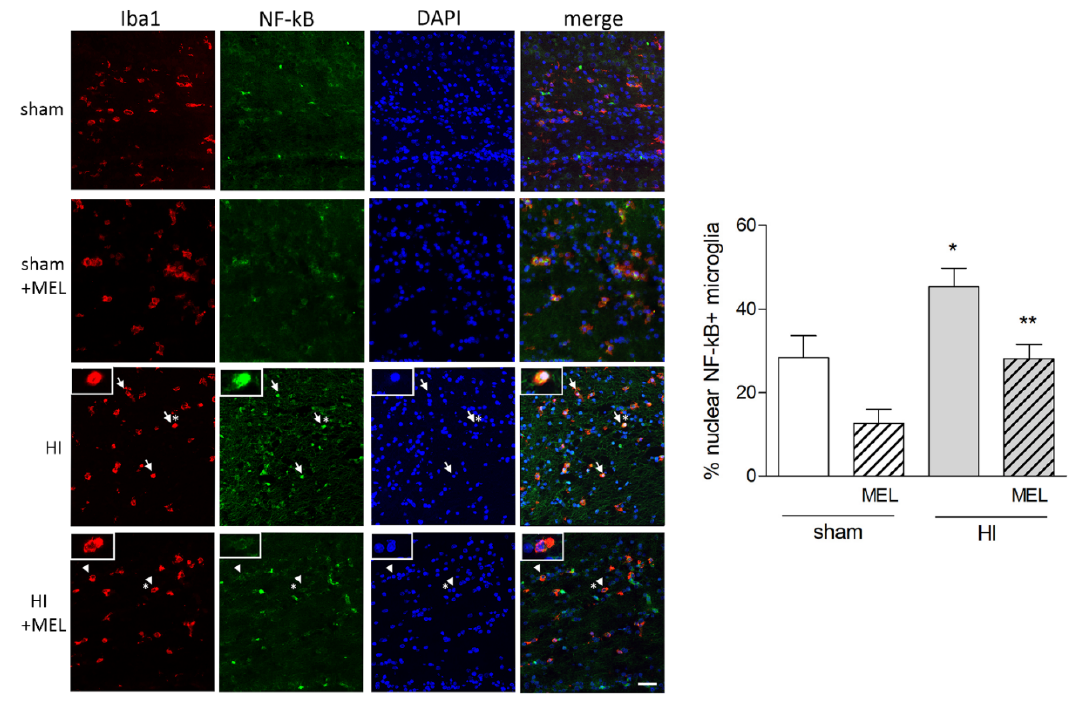
Figure 10. Melatonin antagonises nuclear NF-kB localization in amoeboid microglia of the corpus callosum in rats subjected to CCAO. Seven-day-old rats were subjected to sham surgery or to ligation of the right carotid artery followed by hypoxia (HI) alone or with subsequent injection of melatonin (10 mg/kg; HI + melatonin (MEL). Animals were sacrificed after 24 h. Double immunohistochemical staining of Iba1 (red) and NF-kB (green) with DAPI nuclear counterstaining (blue) is shown. The graph reports the percentage of nuclear SIRT1+, Iba1+ microglial cells in the area. Representative images of ipsilateral CC are shown. Arrows indicate representative Iba+ cells with nuclear NF-kB; arrowheads indicate representative Iba1+ cells with extranuclear NF-kB staining. Asterisks indicate cells reported in the insets at higher magnification. Scale bar = 40 μ m. Bars are mean ± SEM of at least three animals/group. * p < 0.05 vs. sham and ** p < 0.05 vs. HI by one-way ANOVA followed by